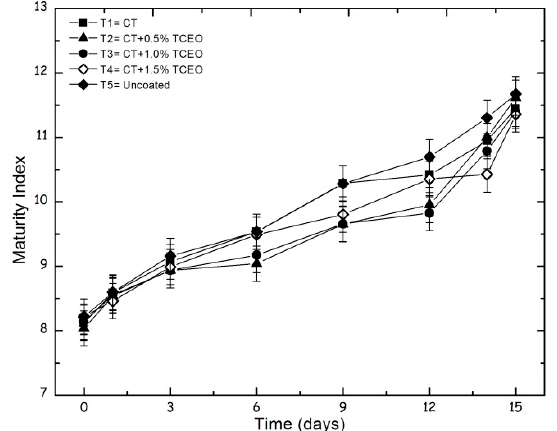
Figure 5. Evolution of the maturity index in strawberries with chitosan (CT) and treatments of oil TCEO: T1 = CT, T2 = CT + 0.5% of TCEO, T3 = CT + 1.0% of TCEO, T4 = CT + 1.5% TCEO, and T5 =